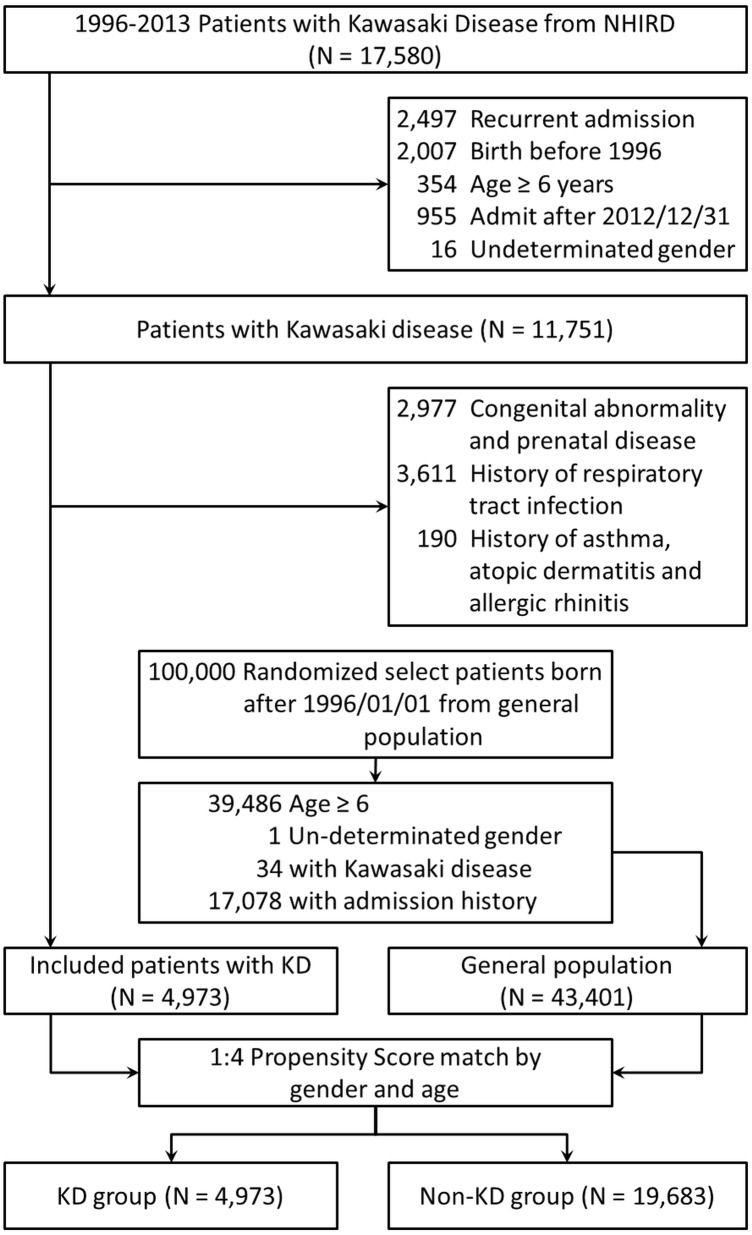
The flow chart of enrollment of study participants.